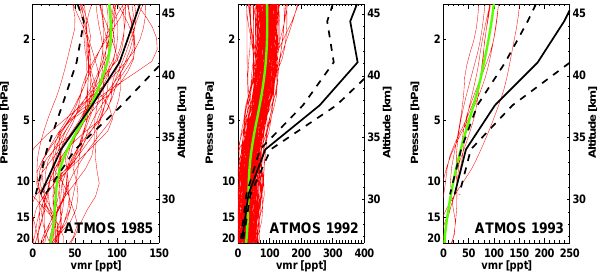
Fig. 11. Global distribution of 1δ l,h as defined in Eq.